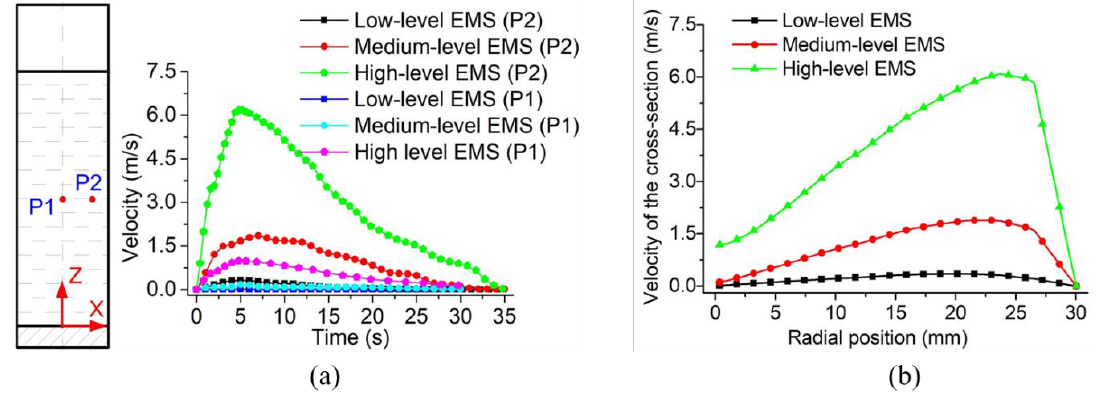
Figure 18. Variation of velocity ( a ) with time and ( b ) along the radius of the slurry.